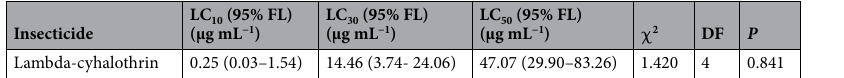
Table 1. Toxicity of lambda-cyhalothrin to housefly adults after 48 h. LC lethal concentration, DF degree of freedom, χ 2 Chi square.